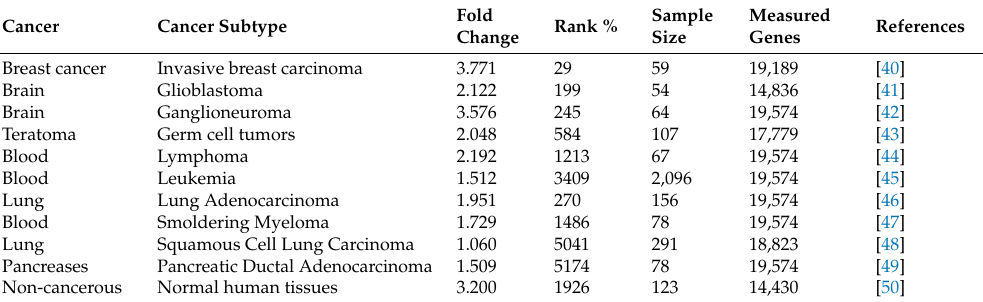
Table 1. Differential expression of SERTAD1 in various types of